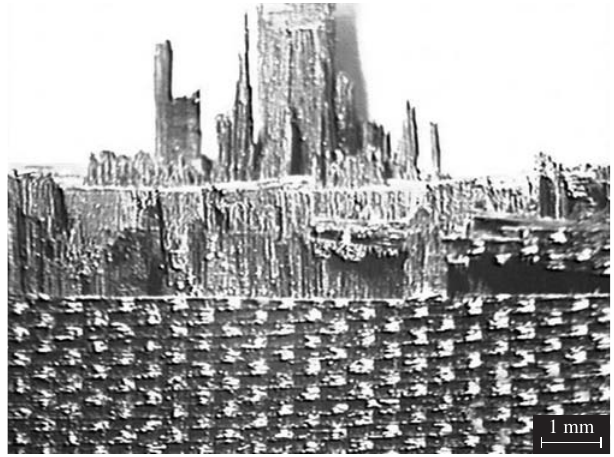
Figure 11. F584/8HS specimen after tensile test,